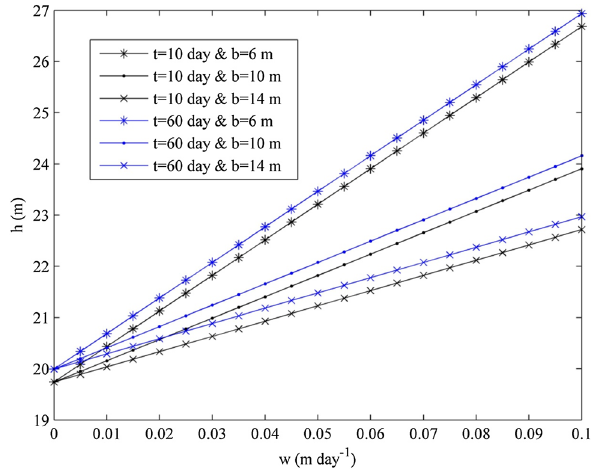
Fig. 7 Variation in hydraulic heads due to changes in recharge rate with different values of hydraulic conductivity